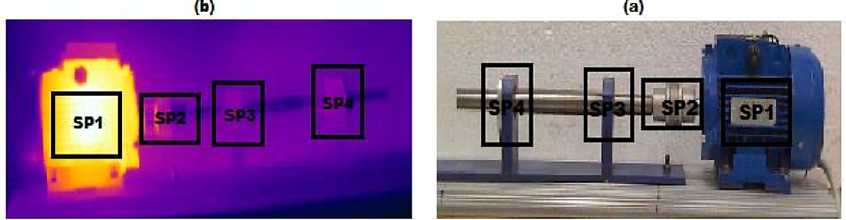
Figure 20. Motor and bearing thermogram: ( a ) experimental setup and kinematic chain and ( b ) ther- mographic image